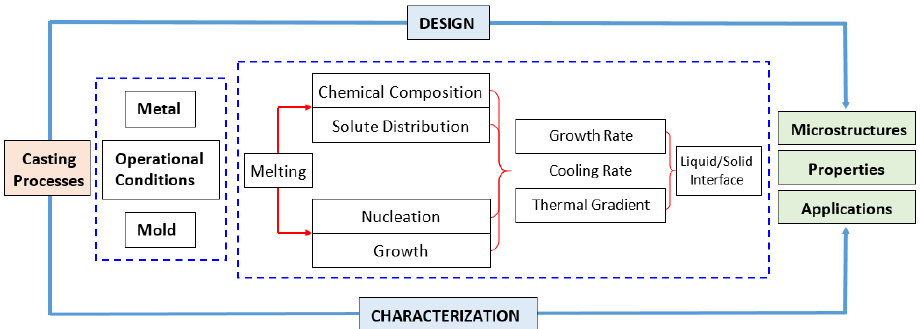
Figure 1. Operational and metallurgical variables during casting processes.